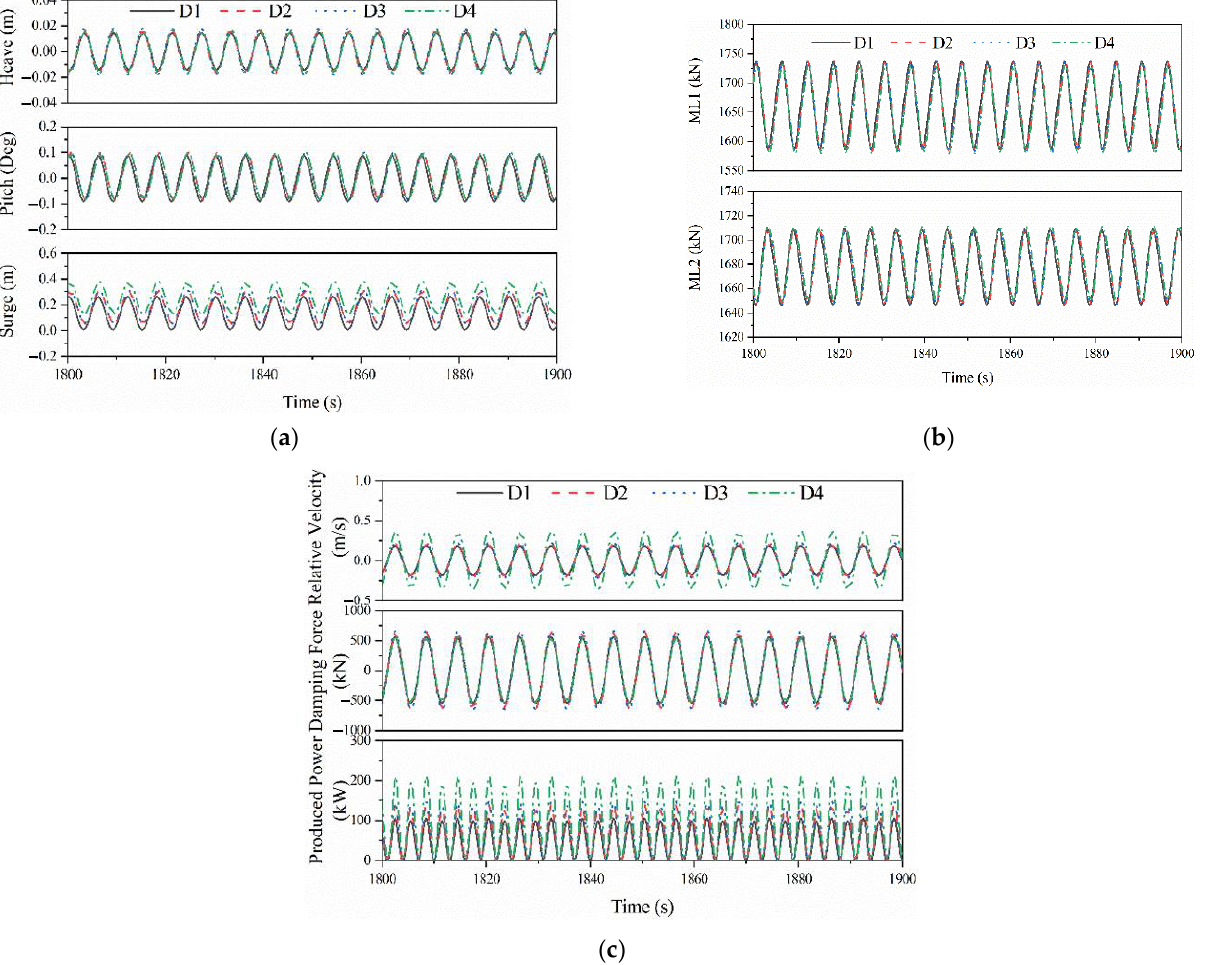
Figure 12. The time domain curves of four different integrated systems. ( a ) Platform Motion. ( b ) Mooring Lines force. ( c ) Produced Power characteristic.